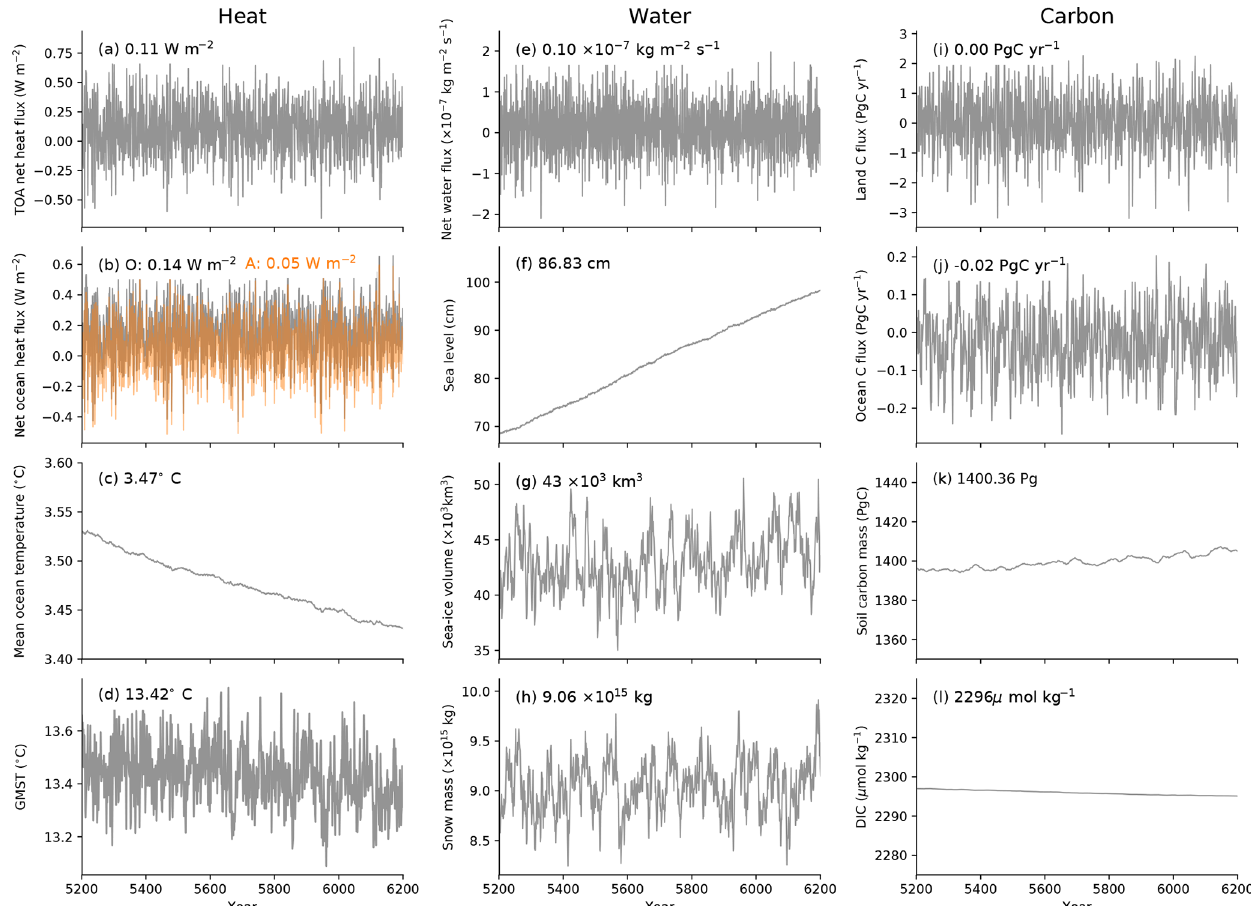
Figure 3. Stability of the CanESM5 piControl run showing global-mean (a) top-of-atmosphere net heat flux, (b) net heat flux at the surface of ocean; (c) volume-averaged ocean temperature; (d) screen temperature; (e) net freshwater input at the liquid ocean surface; (f) dynamic sea level; (g) sea-ice volume; (h) snow mass; (i) land–atmosphere carbon flux; (j) ocean–atmosphere carbon flux; (k) terrestrial soil carbon mass; and (l) ocean-dissolved inorganic carbon concentration. Inset numbers are the time average over the 1000 years shown. Heat fluxes in panels (a) and (b) are reported per metre squared of global area. The orange line in panel (b) is the heat flux computed at the bottom of the atmosphere, while the grey line is the heat flux computed at the surface of the liquid ocean (below sea